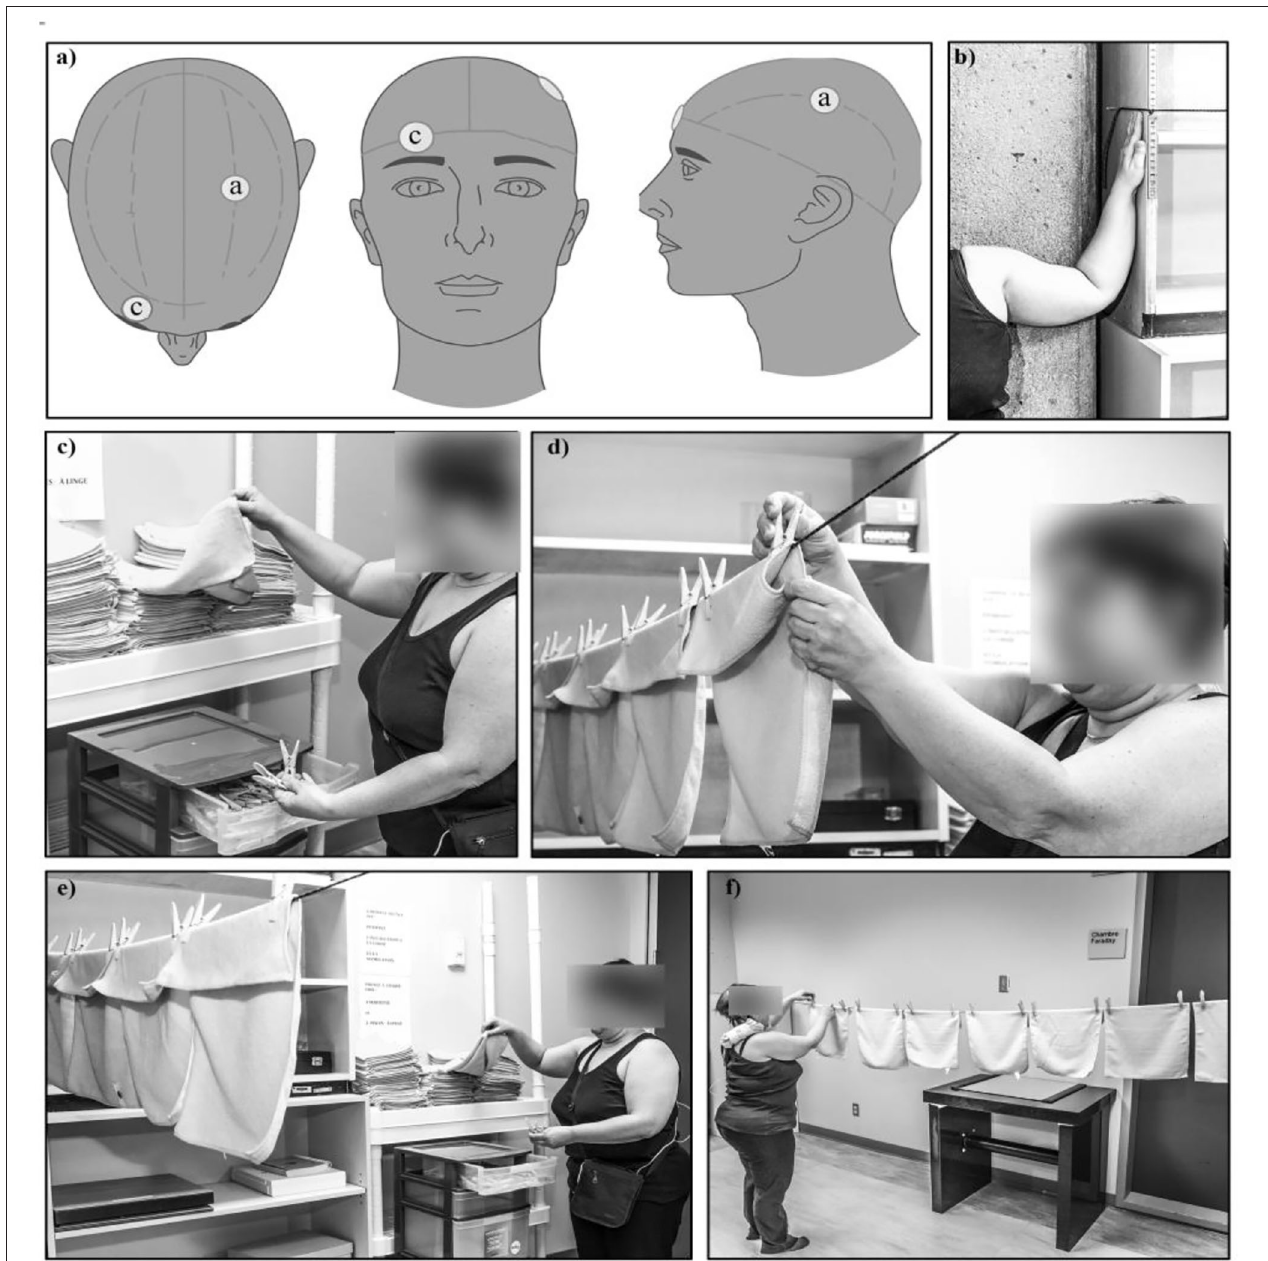
FIGURE 1 | Description of the intervention components. (a) An anode (a) was placed above the C3 area of the primary motor cortex and a cathode (c) was placed over the contralateral orbit. (b) Before the beginning of task performance, the shoulders of participants were moved at 90 ◦ abduction, elbows flexed at 90 ◦ and the height of the clothesline was adjusted at their fingertips. (c) The clothes were placed to a half-meter from the clothesline. The task, in combination with active tDCS, consisted to take one cloth and two pins, then walk to the clothesline and hang it. (d–f) The participant has to perform the task as fast as possible considering their pain intensity and may stop any time. Active tDCS and the domestic task were performed simultaneously for 20min. When the participant reached the end of the clothesline, an experimenter removed the clothes from the line; the participant had to return to the start to continue performing the task. The functional performance consisted of installing as many clothes as possible during the 20min